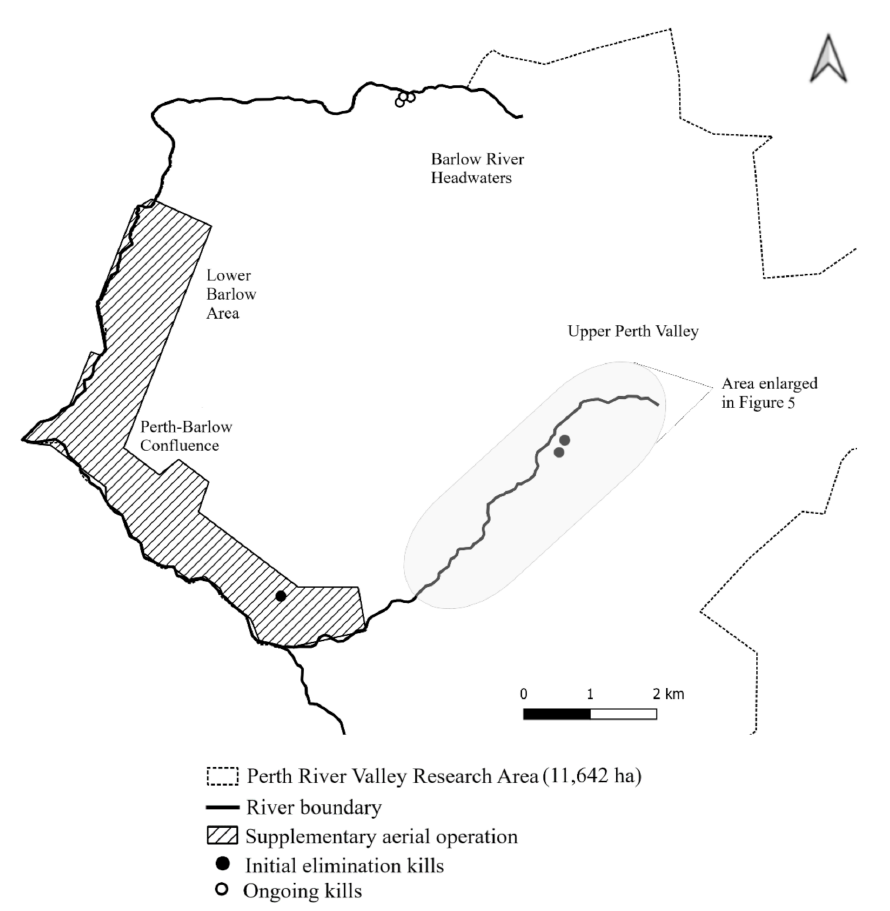
Figure 4. Kill locations of possums in the Perth Valley from 5 May (first body found)